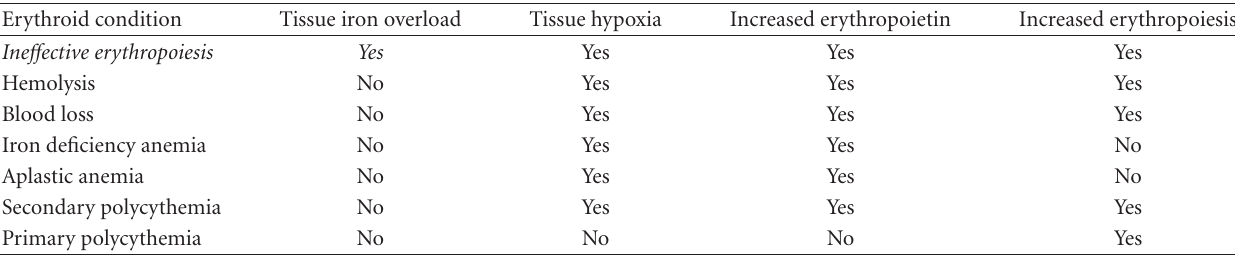
Table 2: A comparison of erythroid